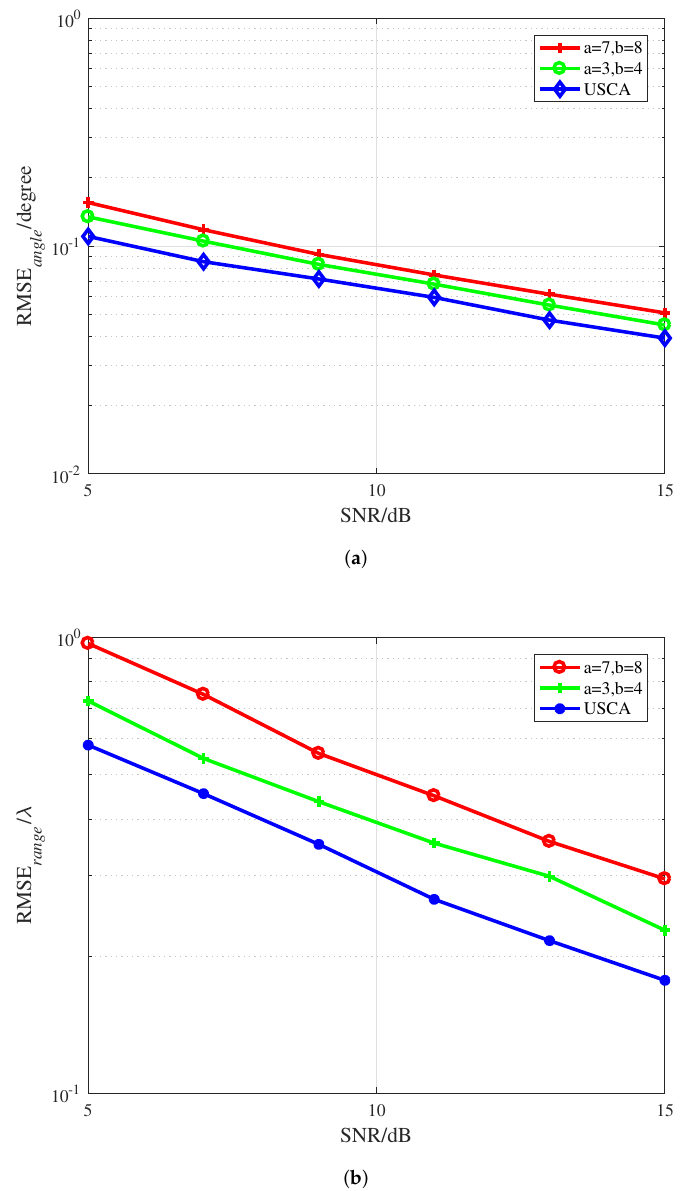
Figure 5. RMSEs versus SNR under different coprime factor pairs with the same subarray aperture. ( a ) DOA estimation. ( b ) Range